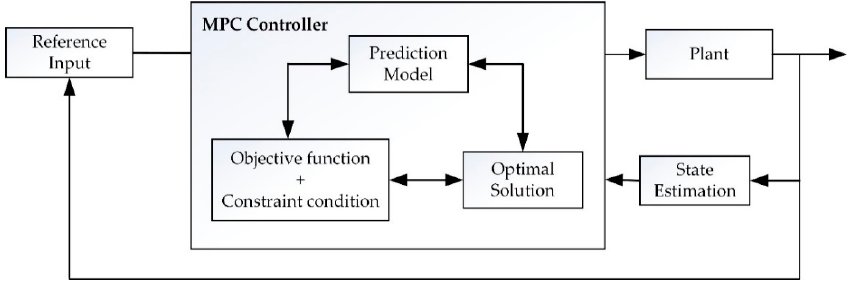
Figure 3. MPC control principle.